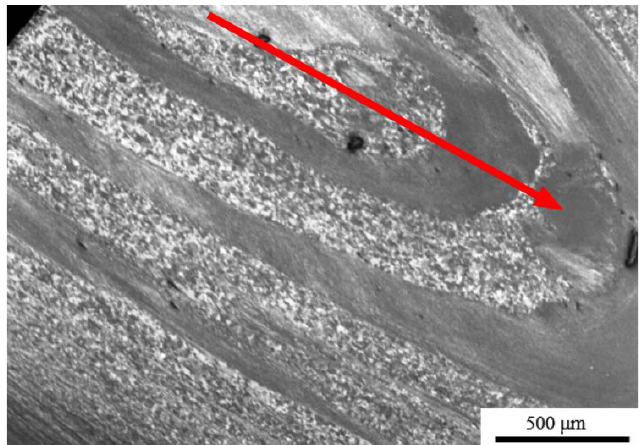
Figure 10. Cross-polarised light micrograph of a transverse section of as-extruded Ti-6Al-4V GA wire. The flow direction, as indicated by the arrow, is evident based on the flow lines across the material. The evolution in grain size and porosity for the GA powder and swarf-derived Ti-6Al-4V wire at different sample locations varied significantly from the initial extruded wire through to the back end of the extrusion (i.e., Samples 1 through 5, respectively). The grain sizes and porosity levels